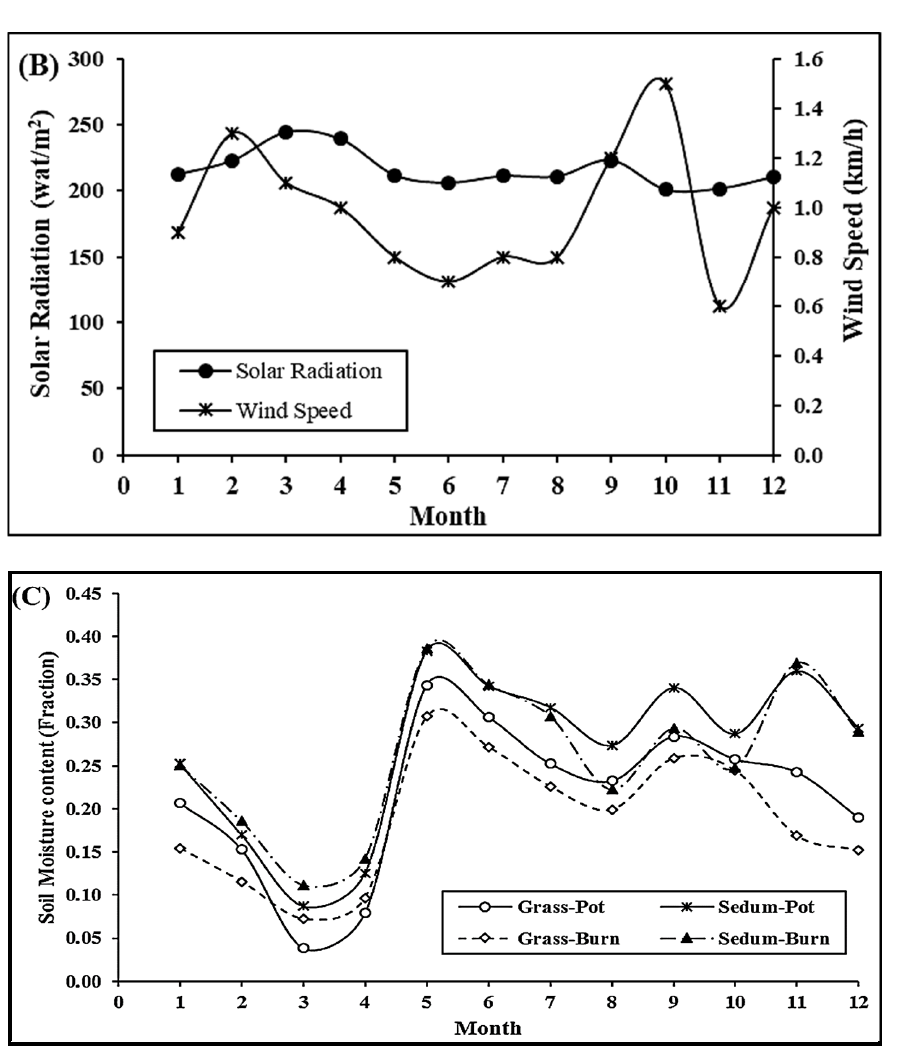
Figure 3. Monthly mean values of ( A ) temperature and relative humidity, ( B ) solar radiation and wind speed and ( C ) soil moisture contents of studied green roofs.